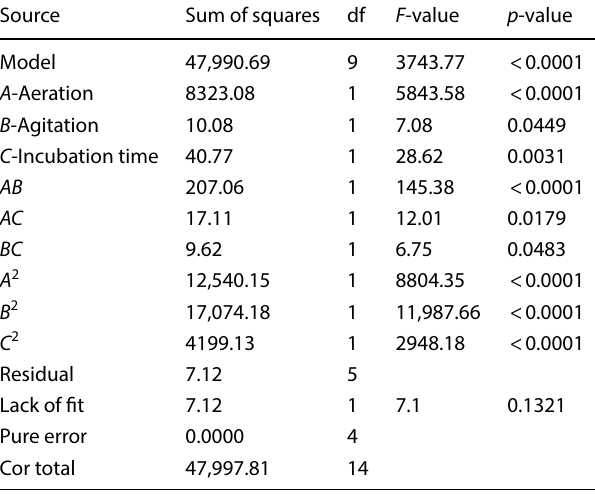
Table 3 Analysis of variance and regression analysis for keratinase production in stirred tank bioreactor